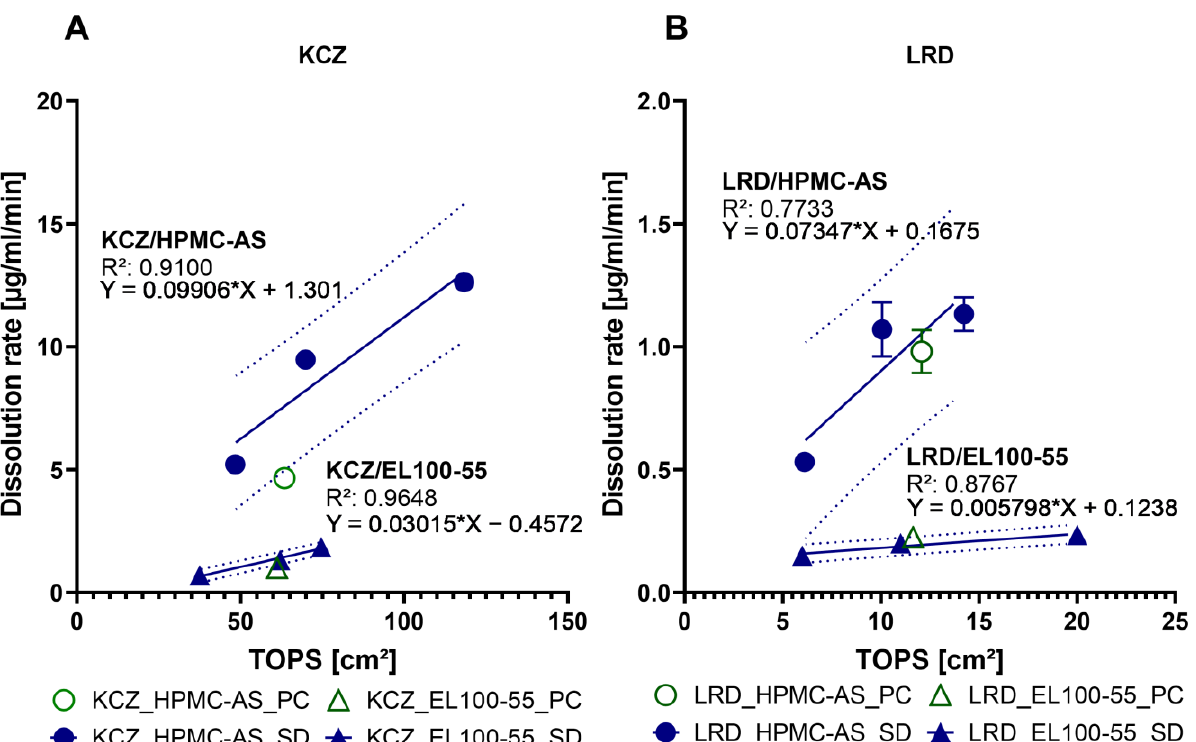
Figure 7. The linear relationship of the dissolution rate in [µg/mL/min] and the TOPS in [cm²] of prepared ASDs, containing: ( A ) KCZ and ( B ) LRD. The pellets represented by the hollow symbols and the SD particle represented by the filled symbols.